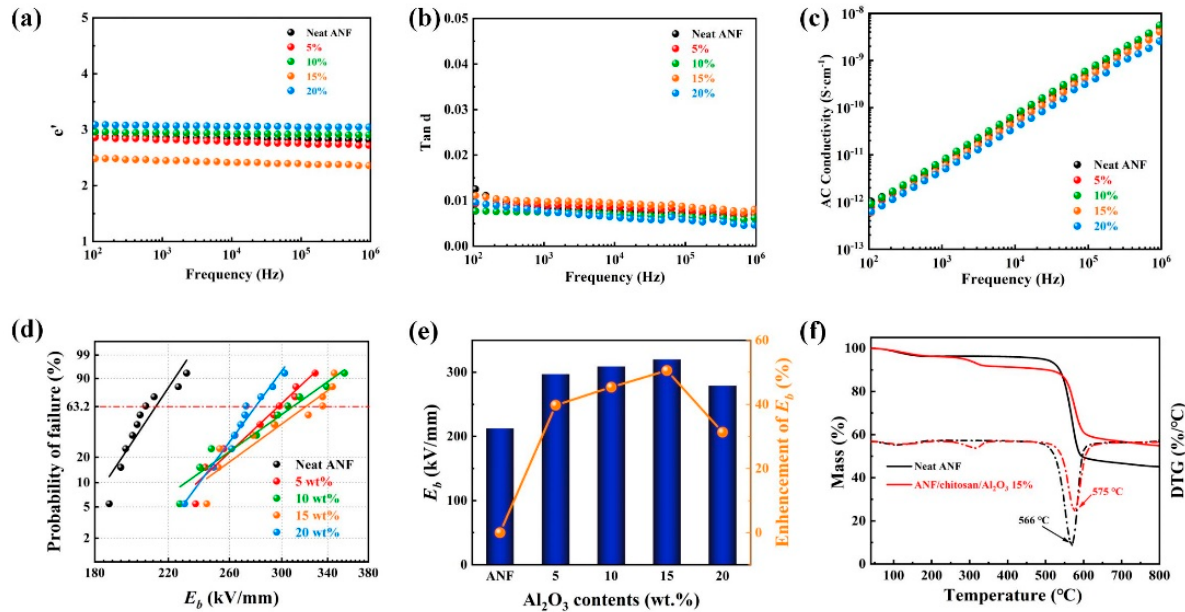
Figure 5. Dielectric properties of ANF/chitosan/Al 2 O 3 composite films. ( a ) The dielectric constant ( ε′ ) and ( b ) loss tangent of ANF/chitosan/Al 2 O 3 composite films as a function of frequency. ( c ) AC conductivity of ANF/chitosan/Al 2 O 3 composite films as a function of frequency. ( d ) Breakdown strength of ANF/chitosan/Al 2 O 3 composite with Weibull distributions. ( e ) The enhancement of the breakdown strength of ANF/chitosan/Al 2 O 3 composites compared with that of the neat ANF film. ( f ) TGA curves of ANF and ANF/chitosan/Al 2 O 3 composite films at 15 wt % filler loading.